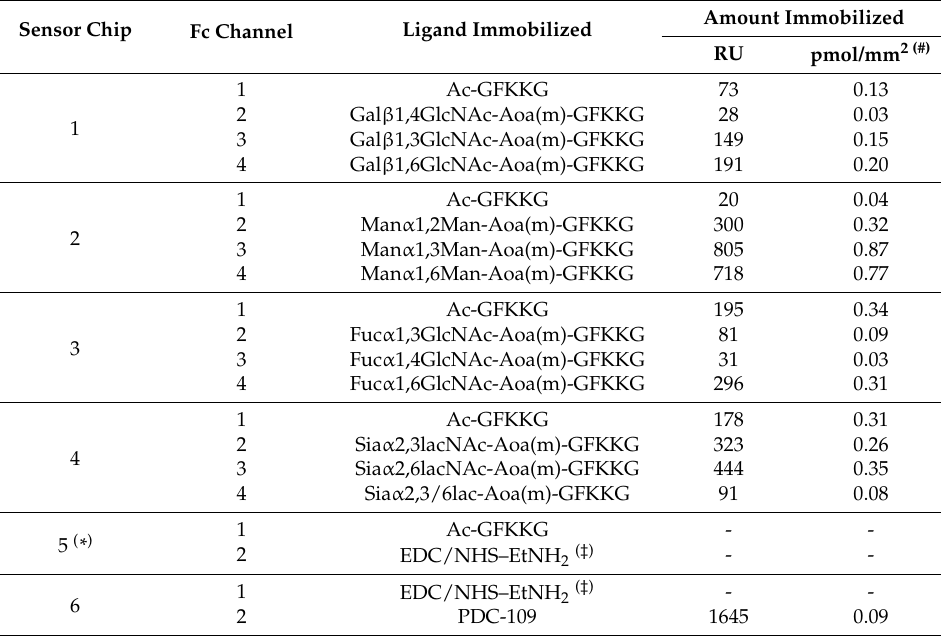
Table 6. Sensor chips prepared during this